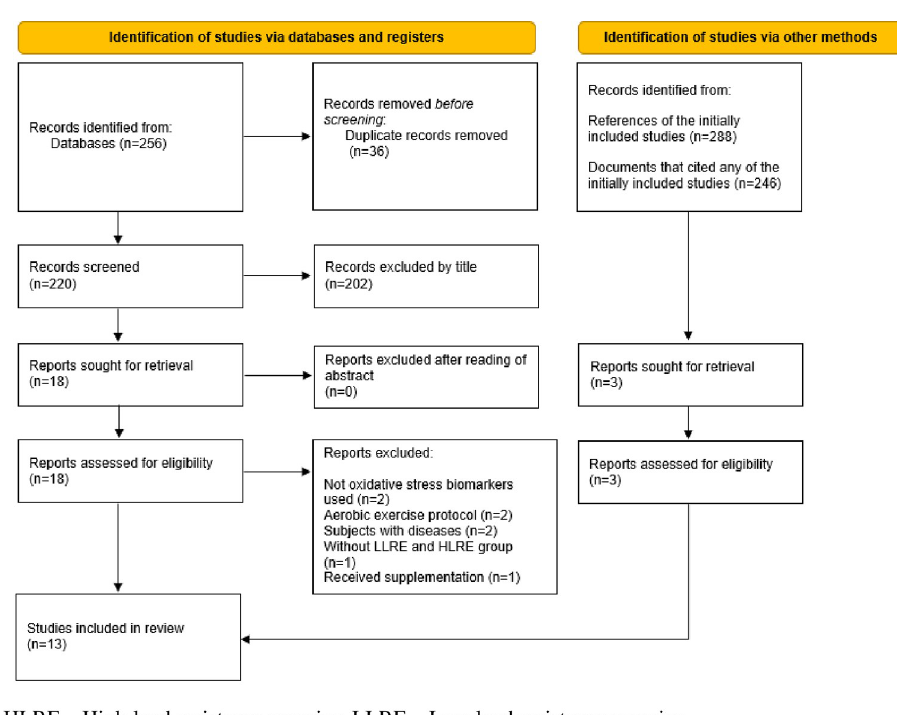
Fig 1. Flow diagram of trials in the review. HLRE–High-load Resistance Exercise; LLRE–Low Load Resistance Exercise.